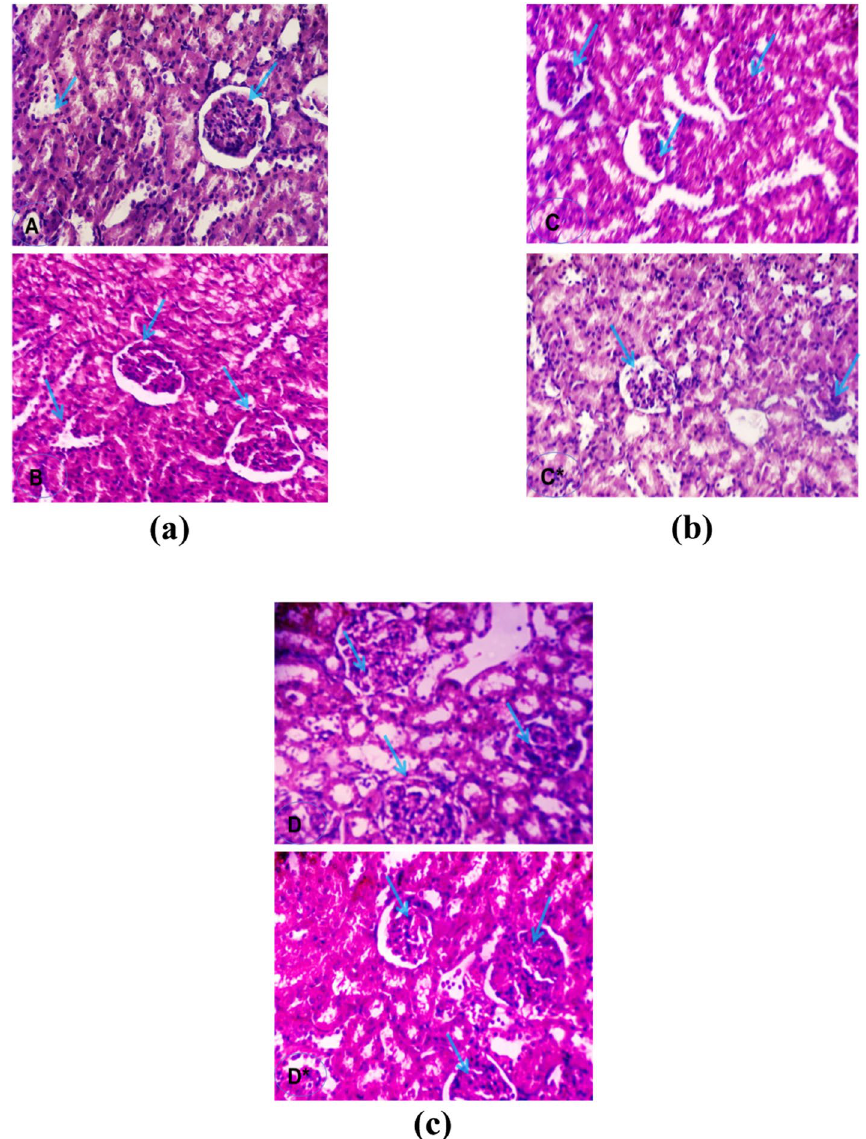
Fig. 2 Kidney section from a control rat group showed normal histology kidney cells before ( A ) and after ( B ) l ‑asparaginase treatment (non‑significant change with respect to control); b treated rat (C&C*) given diethyl nitrosamine DENA (chemotoxic agent) showed the appearance of the corpuscles with high cellularity and obliterated capsular space, proximal convoluted tubules with destructed epithelial lining of distal convoluted tubules, shrunken glomeruli indicating degeneration of nuclei and increased Bowman’s space; c treated l ‑asparaginase (D&D*) showed a reduction of congestion of the blood vessels, the renal cortex of the renal corpuscle with nearly normal glomerulus which restored shrunken glomeruli and Bowman’s